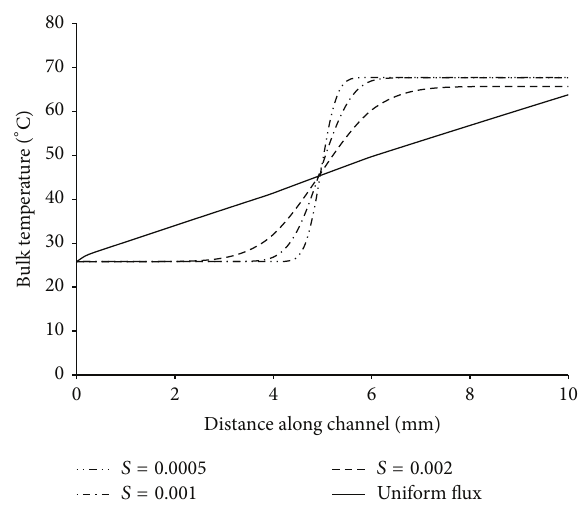
Figure 8: Variations in fluid bulk temperature obtained using different values of SD, when 𝑧 𝑚 = 0.5 , Re = 500, 𝜀 = 0.95 , and 𝐶 = 100 .